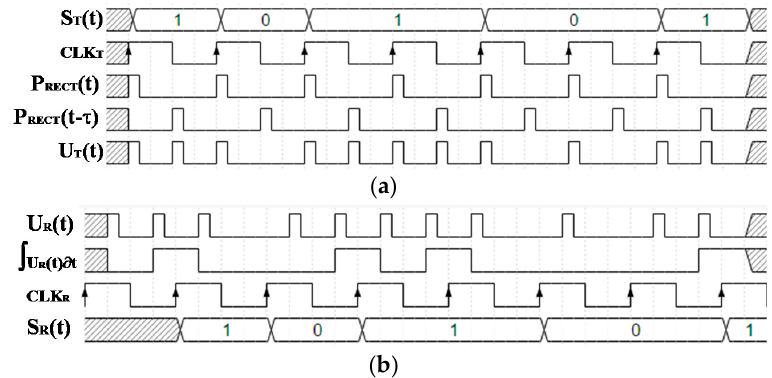
Figure 4. Correlations between the signals CLK T , R , S T , R ( t ) and the corresponding coded data U T , R ( t ) related to the coding ( a ); and decoding ( b ) systems.